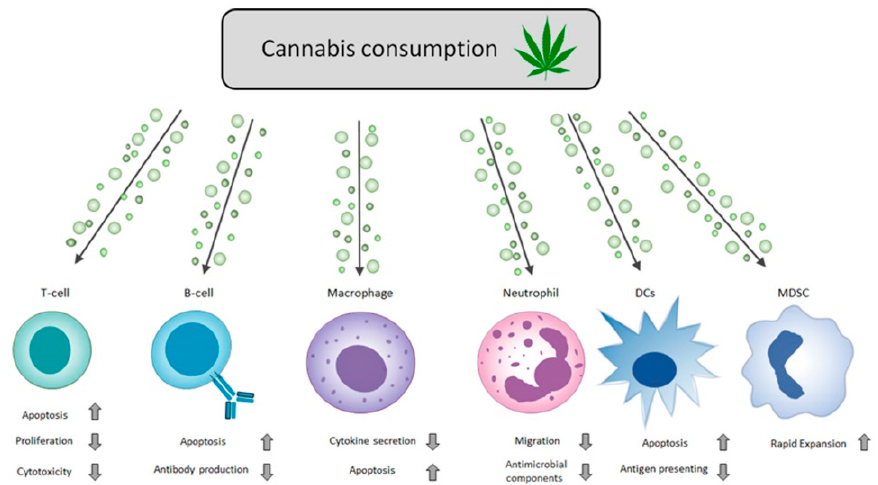
Figure 2. Cannabinoids regulate immune responses. Schematic diagram of cannabis immuno-modulation properties on different effector cells of the immune system. The arrows in the chart above represent the adjacent cellular process’s increase ( up arrow ) and decrease ( down arrow ). Cannabis